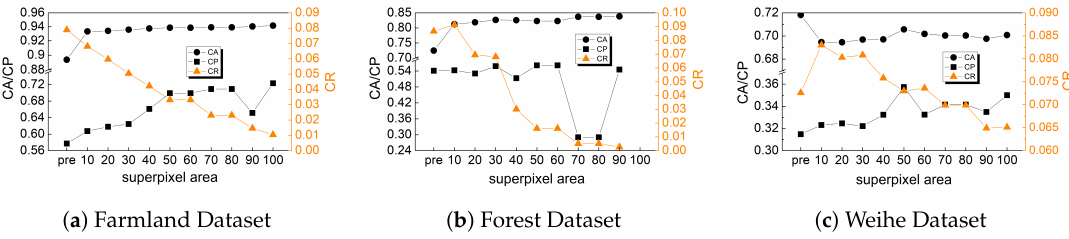
Figure 11. Relationship between parameter superpixel area and the result of sample